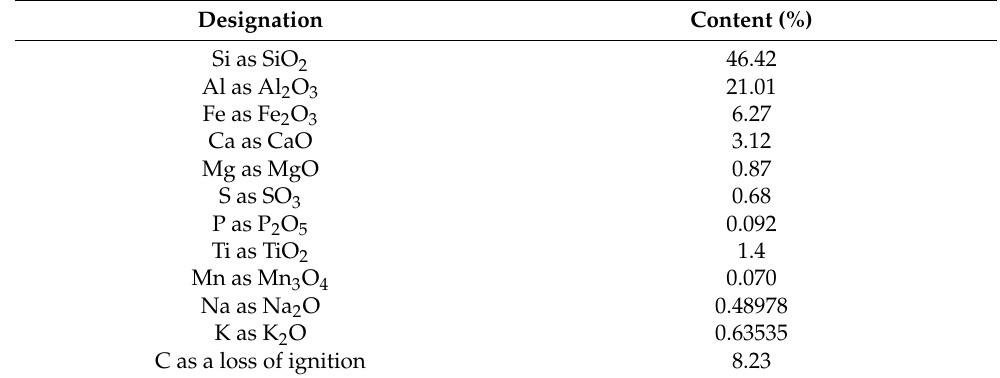
Table 1. The main components of tested fly ash.